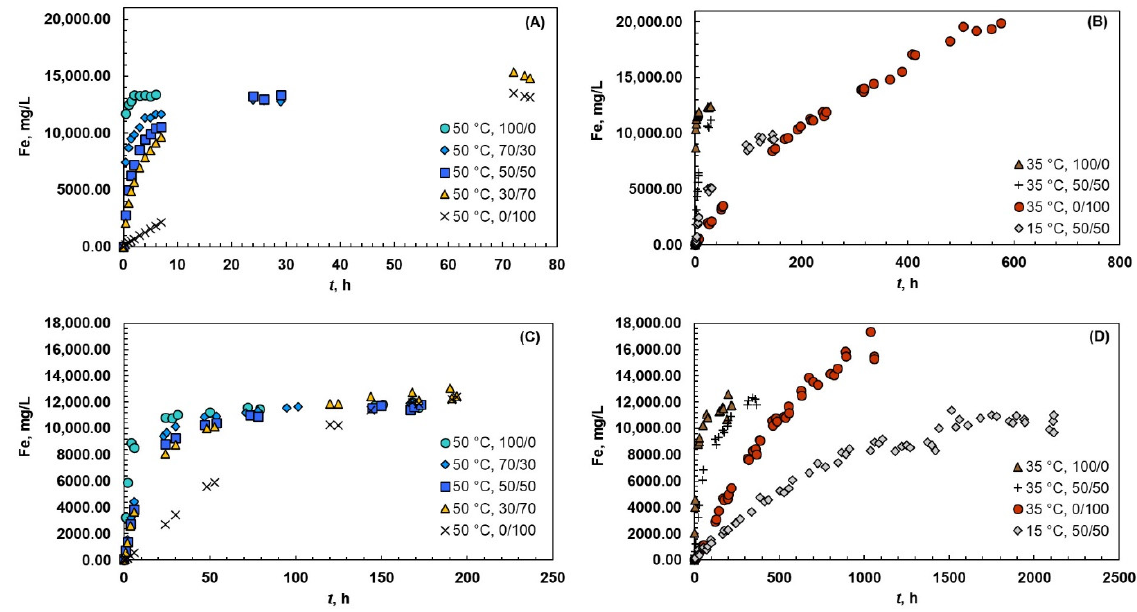
Figure 2. Solubility of iron at 15, 35, and 50 °C and different acid systems (Ox/HNO 3 ). The experiments were carried out with magnetite ( A , B ) and hematite ( C , D ).